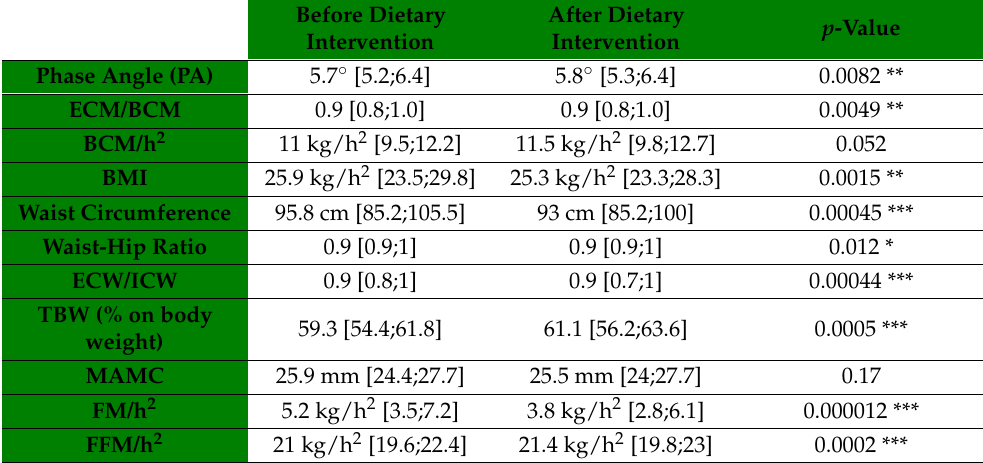
Table 3. Anthropometric indices and parameters at pre- and post-dietary and nephrological interven- tion (annotations follow the format: mean [confidence interval]). * indicates statistical significance for p ≤ 0.05, ** for p ≤ 0.01, *** for p ≤